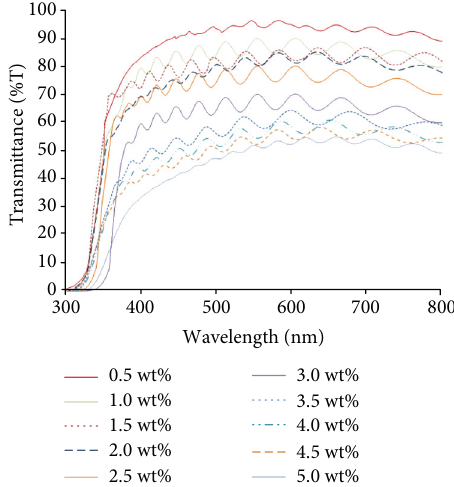
Figure 6: Optical transmittance of the deposited ITiO fi lms of di ff erent doping concentrations from Ti-0.5wt% to Ti-5.0wt%.